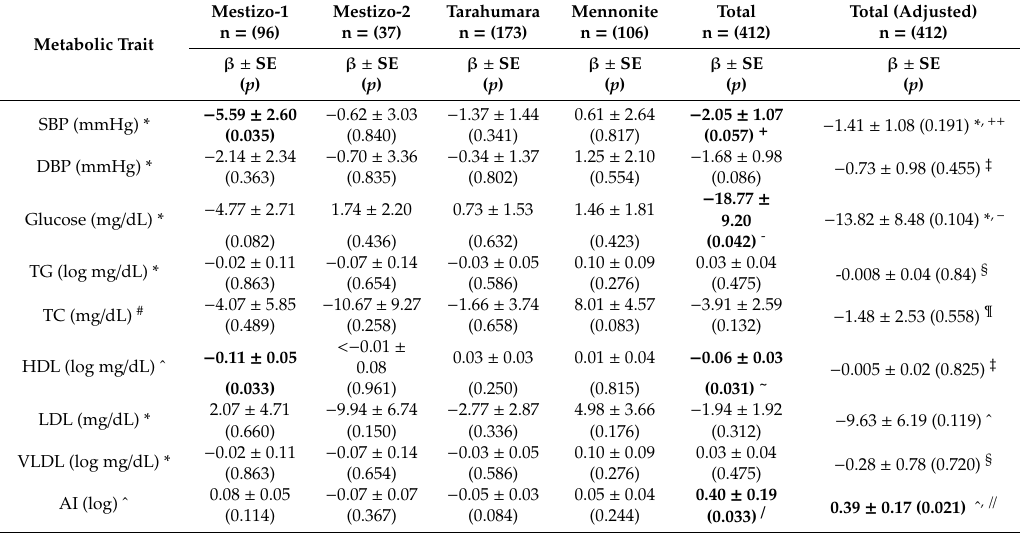
Table 6. Association / Interaction between Pro12Ala PPAR- γ 2 polymorphism and metabolic traits by population groups.